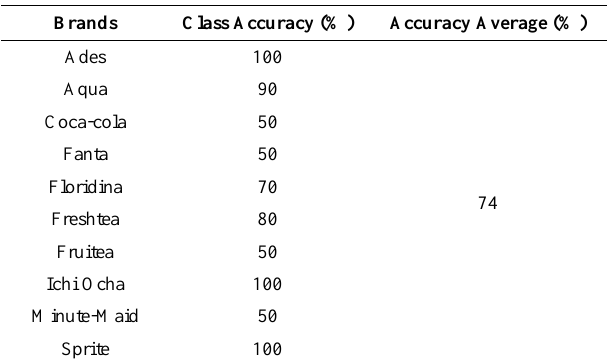
Table 3. Result Testing